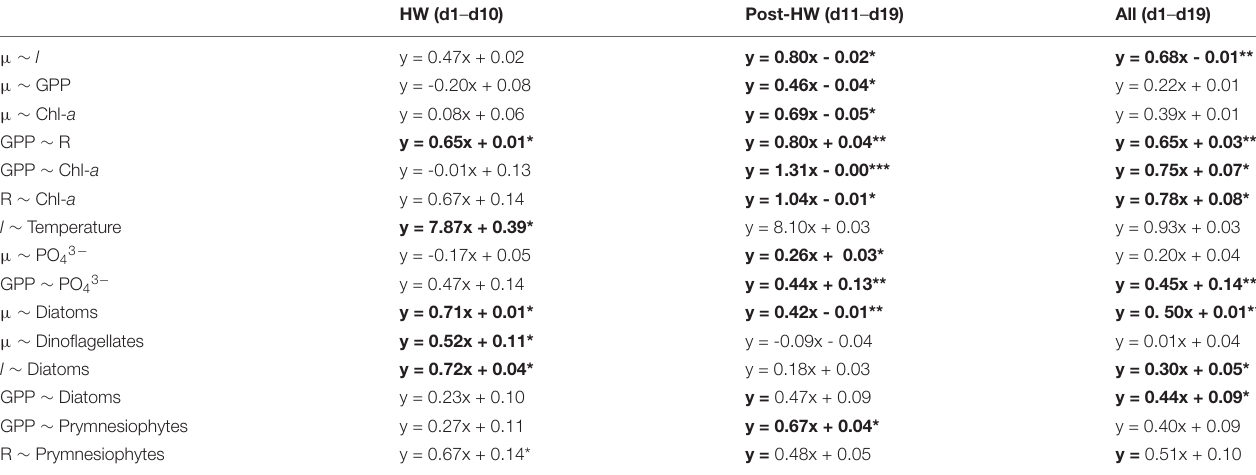
TABLE 4 | Ordinary least squares linear relationships between plankton community metabolism, PFTs, and environmental variables.